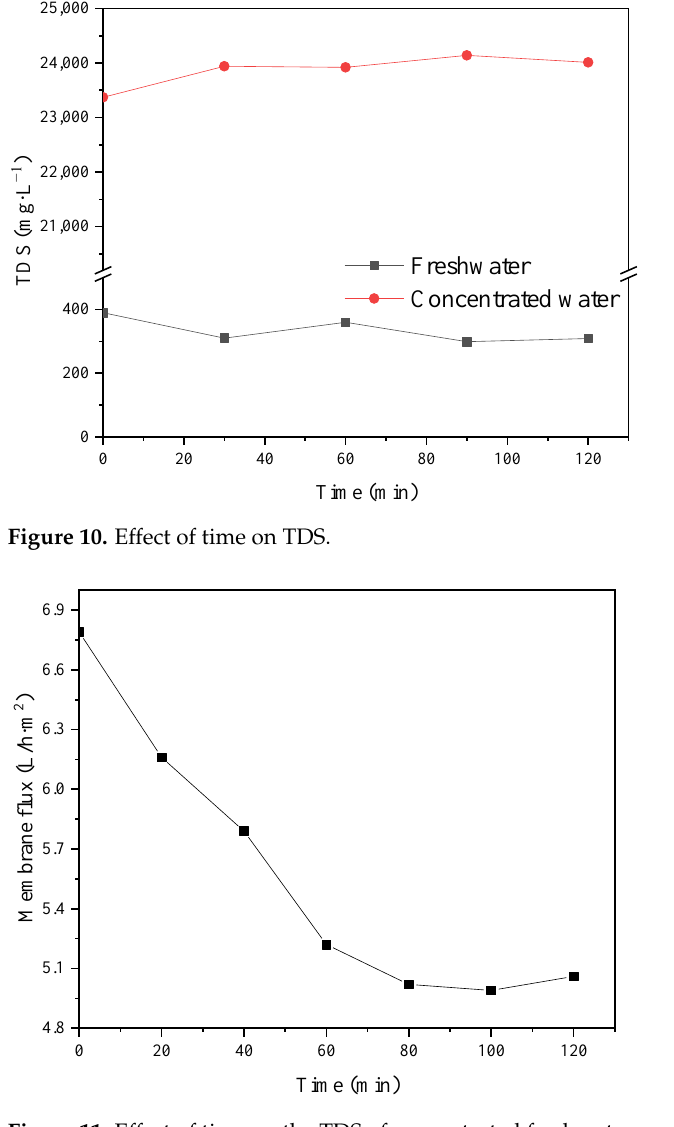
Figure 11. Effect of time on the TDS of concentrated freshwater.